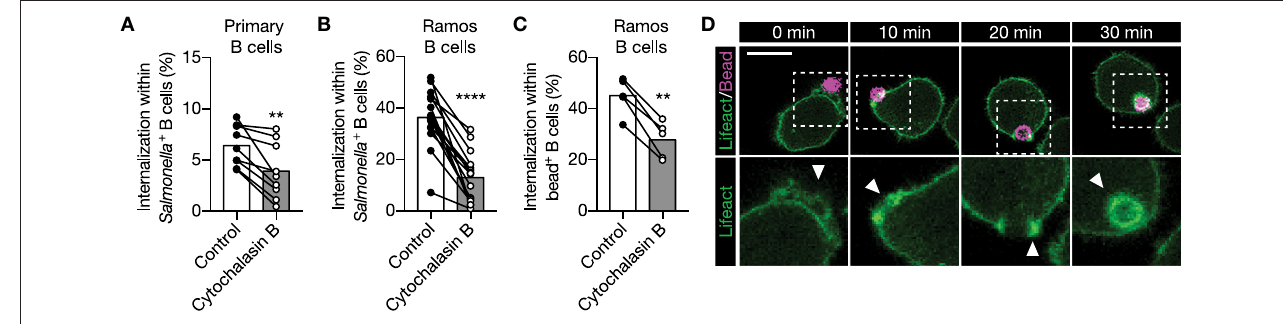
FIGURE 4 | IgM - BCR-mediated large particle internalization is an actin-dependent process. (A–C) Proportion of internalization within S. typhimurium + (A,B) or polystyrene bead + (C) primary human B cells [ (A) ; n = 9], and Ramos B cells [ (B) ; n = 16, (C) ; n = 5] after treatment with cytochalisin (B) . (D) Representative confocal still-images at different time points imaging internalization of anti-IgM-coated polystyrene beads by Ramos B cells expressing Lifeact-GFP. Arrowhead, clusters of actin driving internalization. Bar, 10 µ m. The boxed region at the upper panels is enlarged at the lower panels. Each data point represents the mean of an individual experiment with duplicate measurements. ** P < 0.01; **** P < 0.0001 by paired t